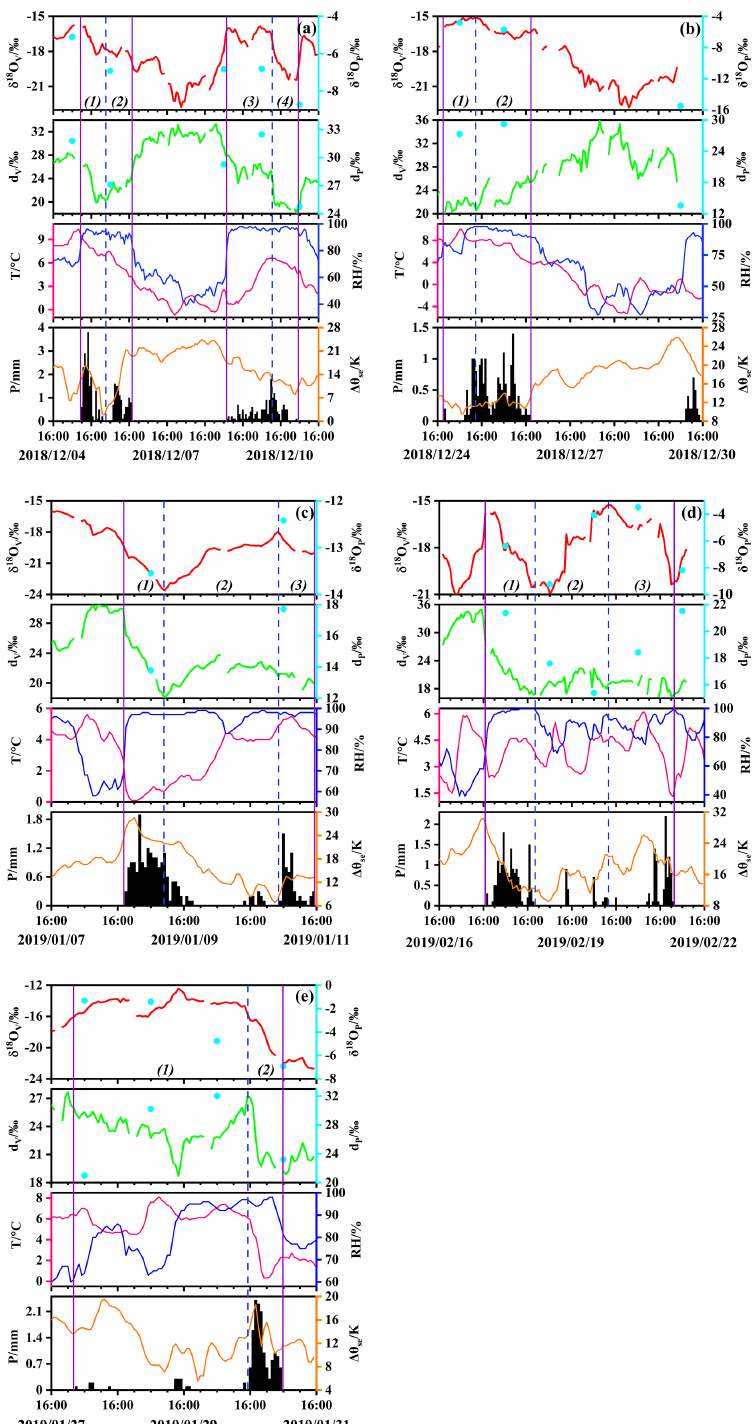
Figure 2. Time series of hourly water vapor ( δ 18 O v and d v ), daily precipitation ( δ 18 O p and d p ; cyan dots), air temperature ( T ), relative humidity (RH), precipitation amount ( P ), and atmospheric stability ( (cid:49)θ se ) at Nanjing. Atmospheric stability is the difference between the pseudo-equivalent potential temperature of 700 and 850hPa ( (cid:49)θ se = θ se700 − θ se850 ). (a) The event on 4–11 December 2018. (b) The event on 24–30 December 2018. (c) The event on 7–11 January 2019. (d) The event on 16–22 February 2019. (e) The event on 27–31 January 2019. The vertical purple lines and blue dashed lines indicate the concentrated rainfall period and different stages of each precipitation event,